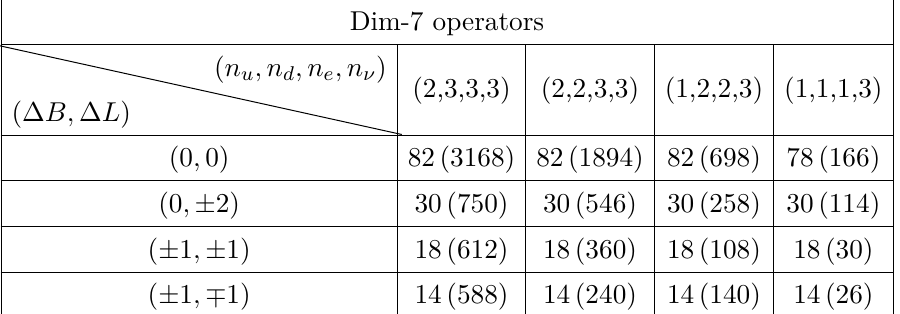
Table 6 . The number of types (operators) of each baryon-number and lepton-number violation pattern with various flavor numbers at dimension 7. n of up-type quarks, down-type quarks, charged leptons and neutrinos respectively. For n n u = 1 , the corresponding active up-type quarks are ( c, u ) and ( u ) respectively, For n d = 3 , 2 , 1 , active down-type quarks are ( b, s, d ) , ( s, d ) and ( d ) respectively, n charged letpons ( τ, µ, e ) , ( µ, e ) and ( e ) .